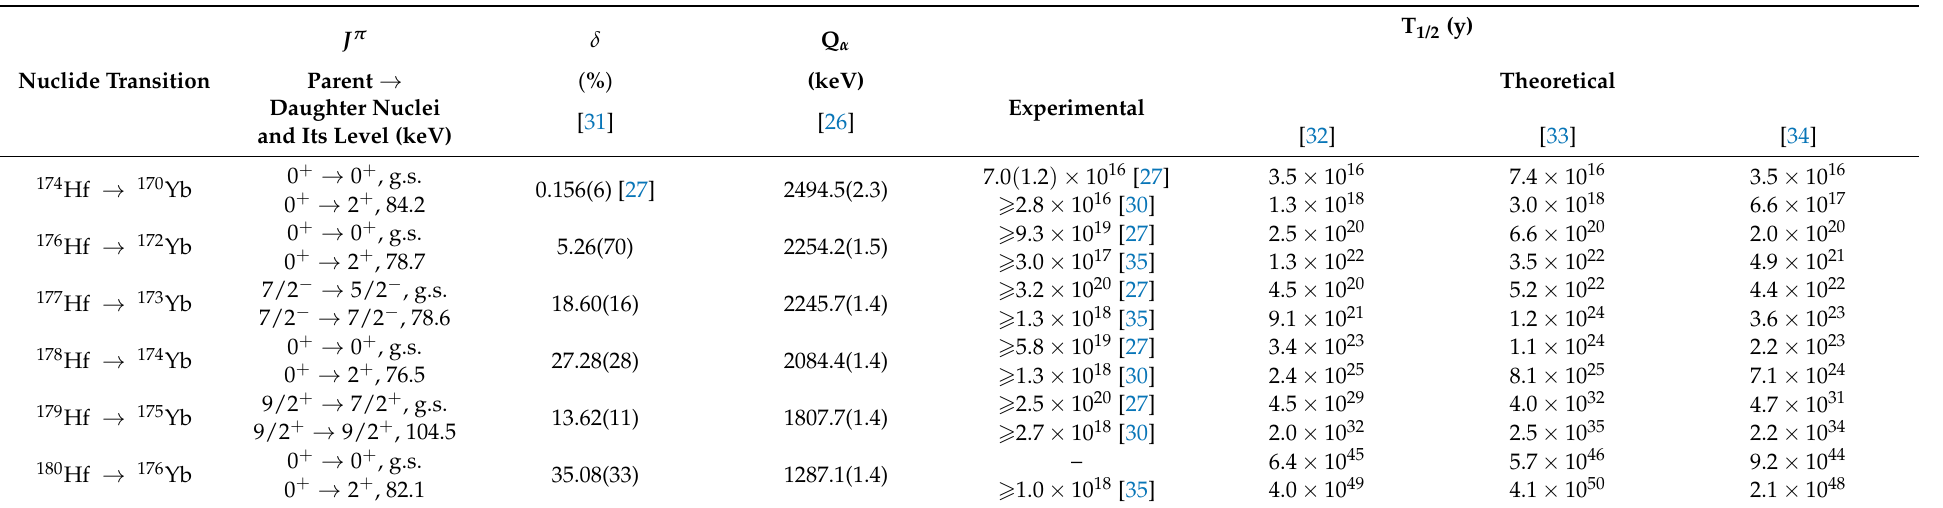
Table 3. Main potential α decay of Hf nuclides. Isotopes with natural abundance ( δ ) greater than zero (i.e., naturally present in nature) and with Q α > 0 for transitions between g.s. or between g.s. and lowest bounded level (with spin/parity J π ) are listed. Theoretical predictions and experimental measurements (if exist) on the T 1/2 ’s are reported in the latest